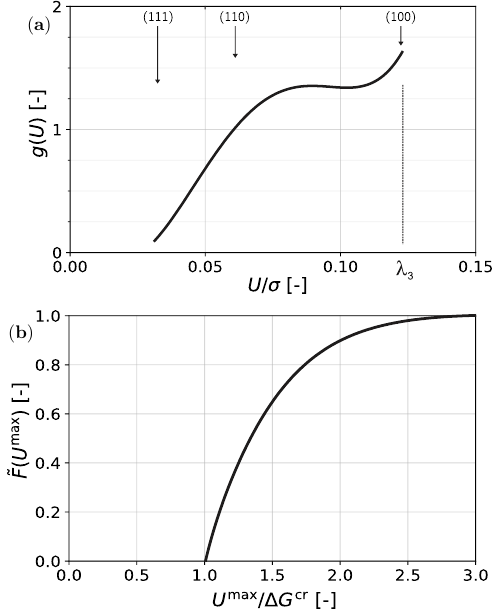
Figure 2. Transformation kinetics of austenitic stainless steel under uni-axial tensile stress: ( a ) distri- bution of driving force and ( b ) amount of transformation function ˜ F ( U )